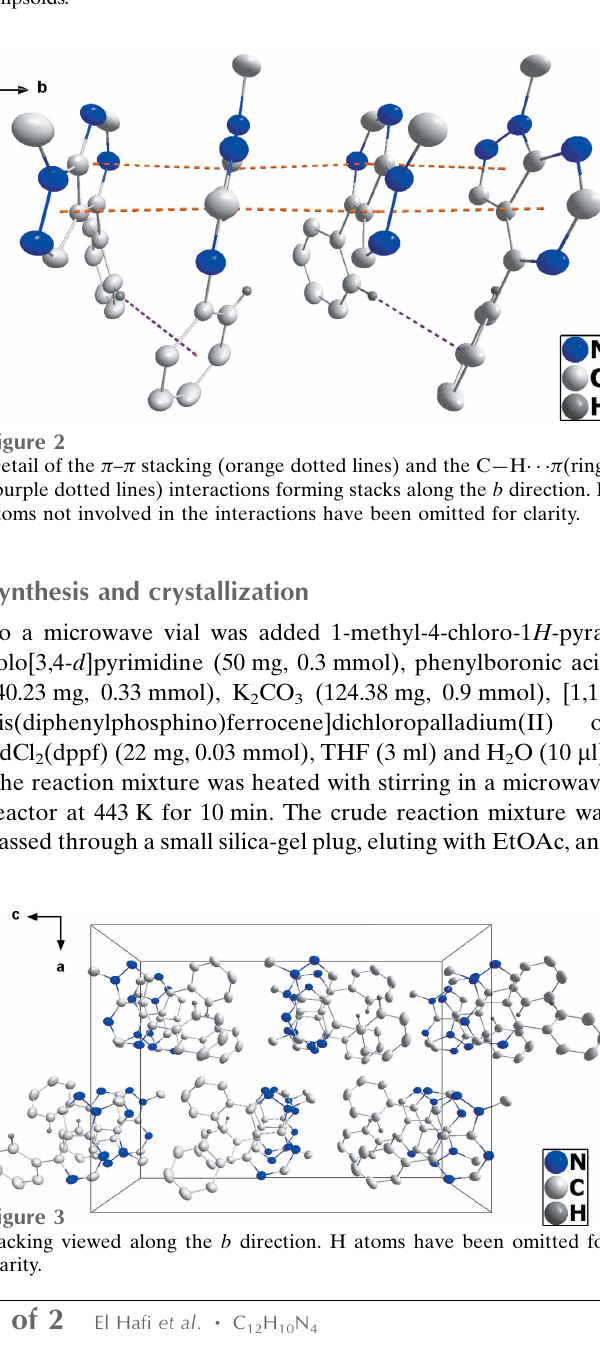
Figure 1 The title molecule, with the atom-labelling scheme and 25% probability ellipsoids.